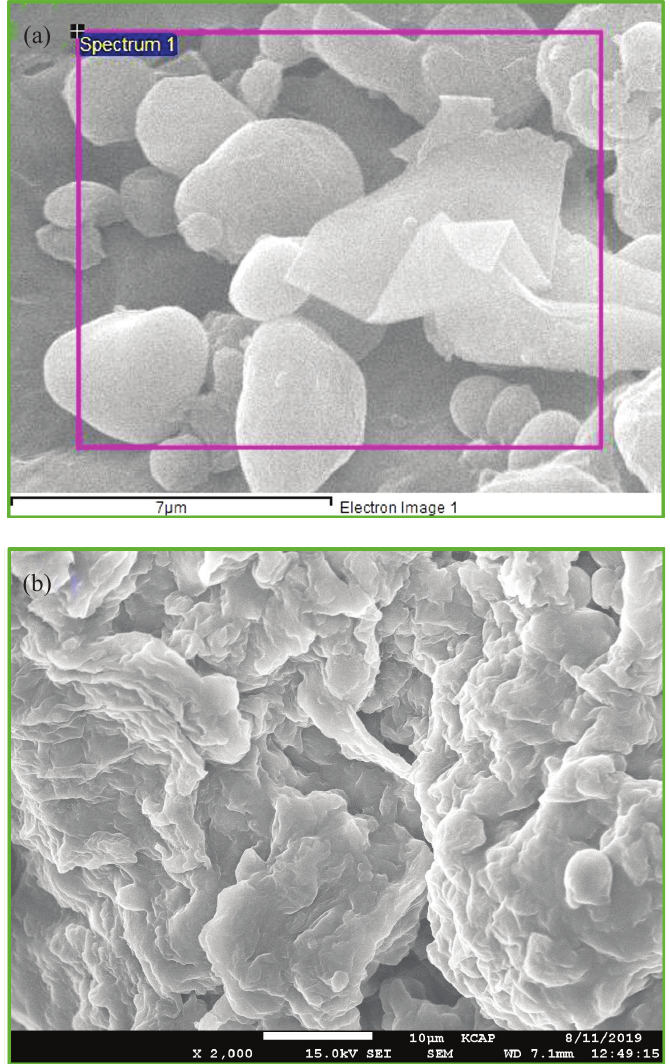
Fig. 3 – Scanning electron microscopic (SEM) image of (a) raw Acorus calamus (RAC), (b) citric acid modified Acorus calamus